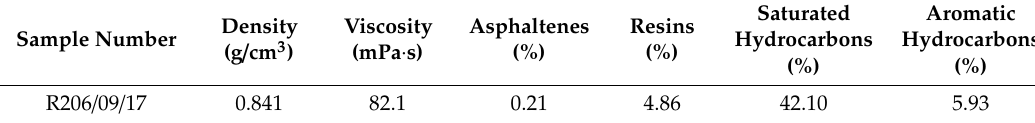
Table 3. Dead oil composition analysis.